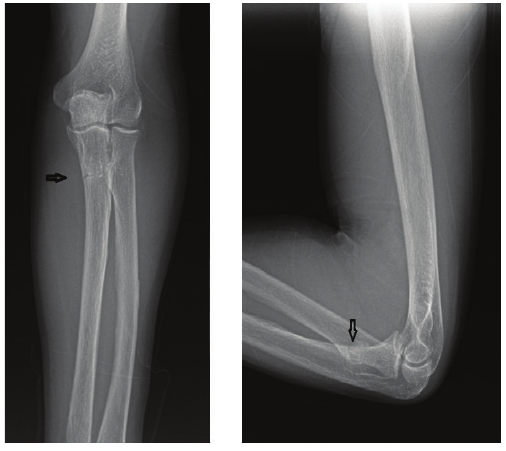
Figure 2: Anteroposterior and lateral X-rays showing stress fracture in proximal metaphysis of left ulna.